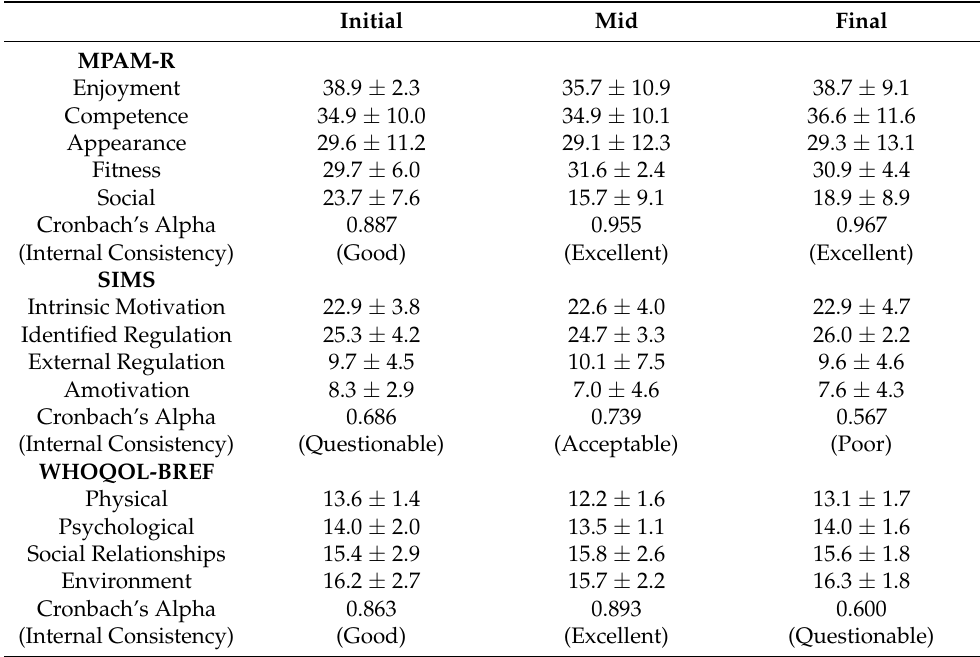
Table 2. Results for Psychological